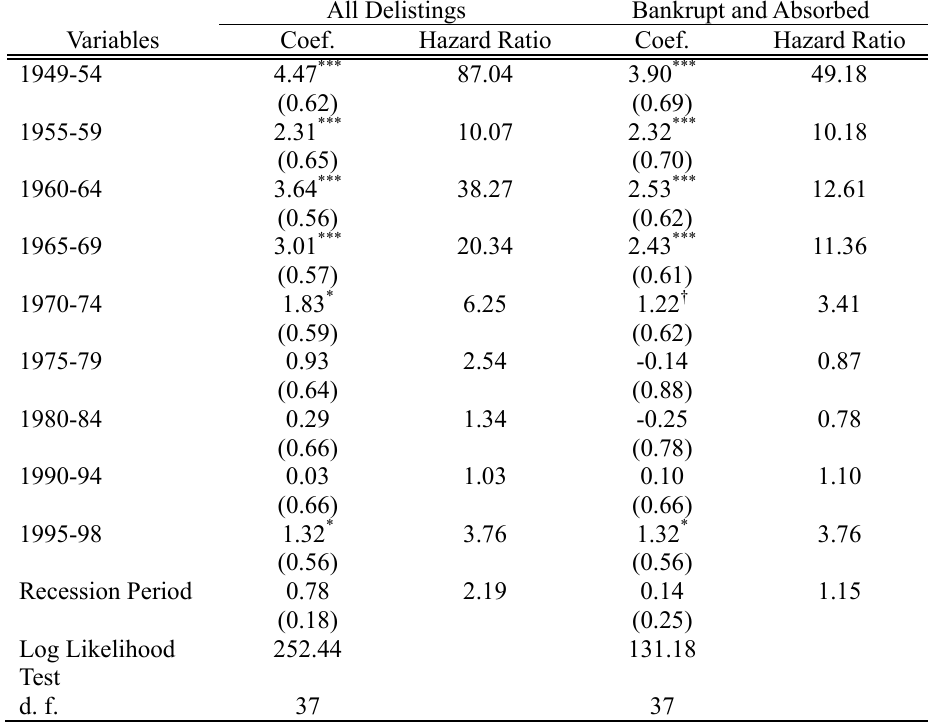
Table 3. Cox Regression Model for the Effects of the Times All